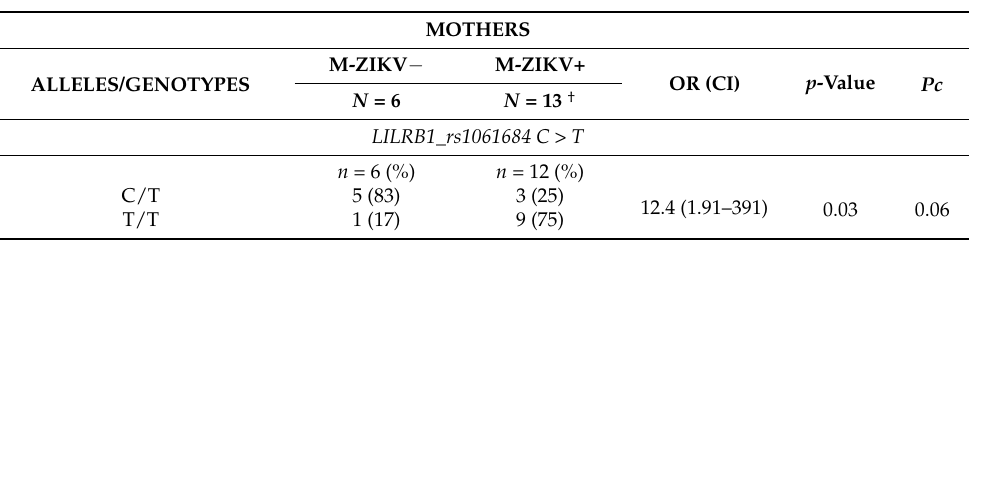
Figure 1. Graphical representation of similarity and dissimilarity genotypes for each gene variant analyzed among ZIKV non-transmitting mother–child and ZIKV-transmitting mother–child pairs. Table 1. Statistically significant allele and genotype distribution for LILRB1 , LILRB2 and HLA-G polymorphisms in mothers who vertically transmitted or not the ZIKV to their